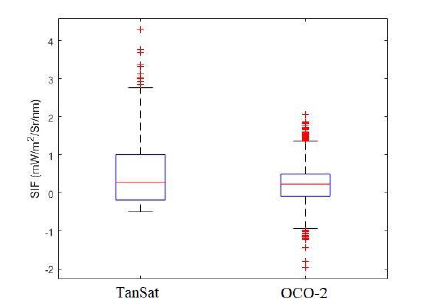
Figure 7. Box-plot of retrieved TanSat SIF against OCO-2